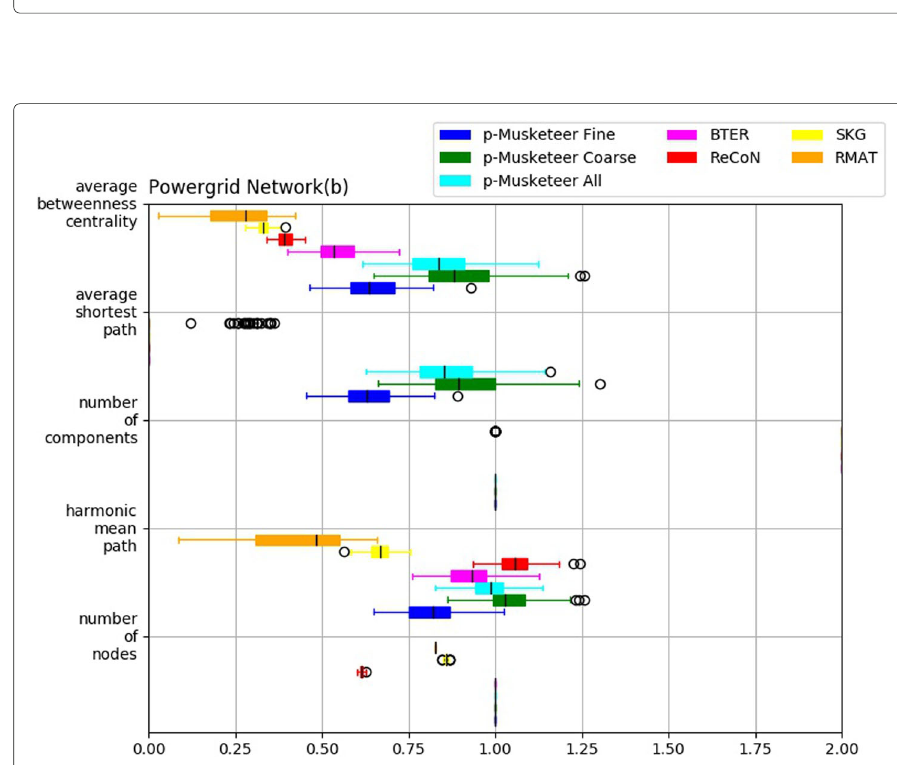
Fig. 3 Computational results on performance of planar Musketeer on power grid graph opsahl-powergrid with 4941 nodes and 6211 edges for number of nodes, harmonic mean path, number of components, average shortest path and average betweenness